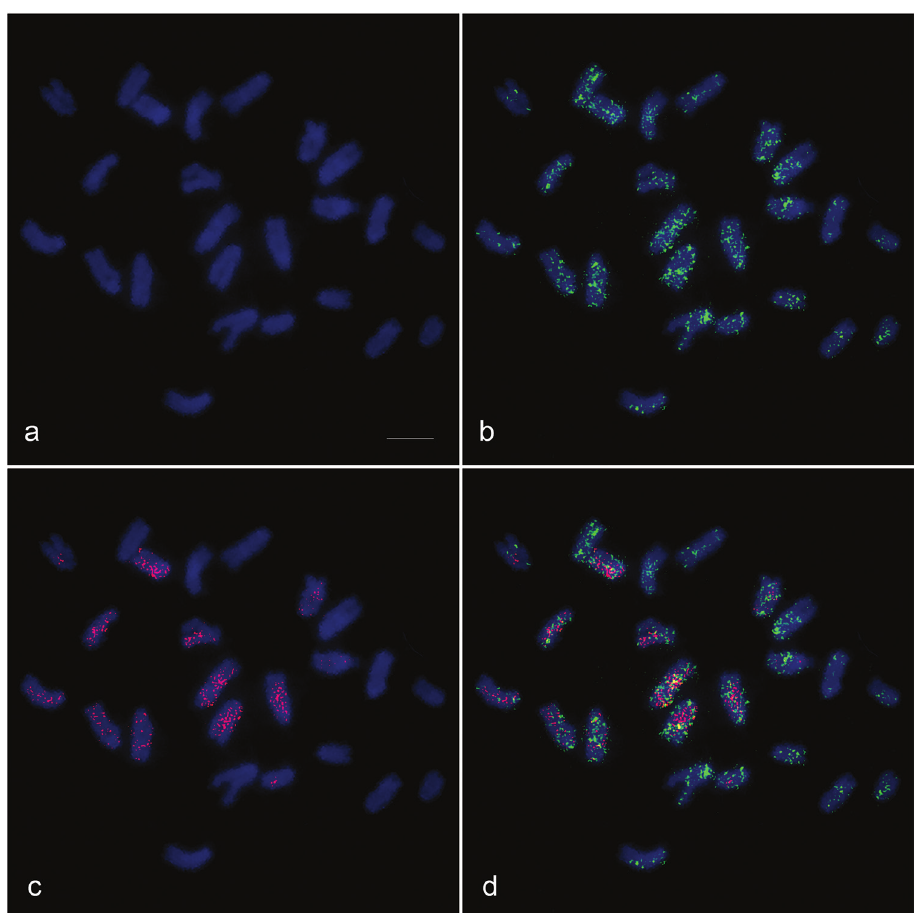
Figure 5. Chromosomal locations of Rex3 and Rex6 in Monopterus albus . Hybridization pattern of FITC- labeled Rex3 (green) ( b ) and rhodamine-labeled Rex6 (red) ( c ) on DAPI-stained chromosomes, and their co-hybridization pattern ( d ). DAPI-stained patterns of the same metaphase spreads of ( b, c, and d ) is shown in ( a ). Scale =10